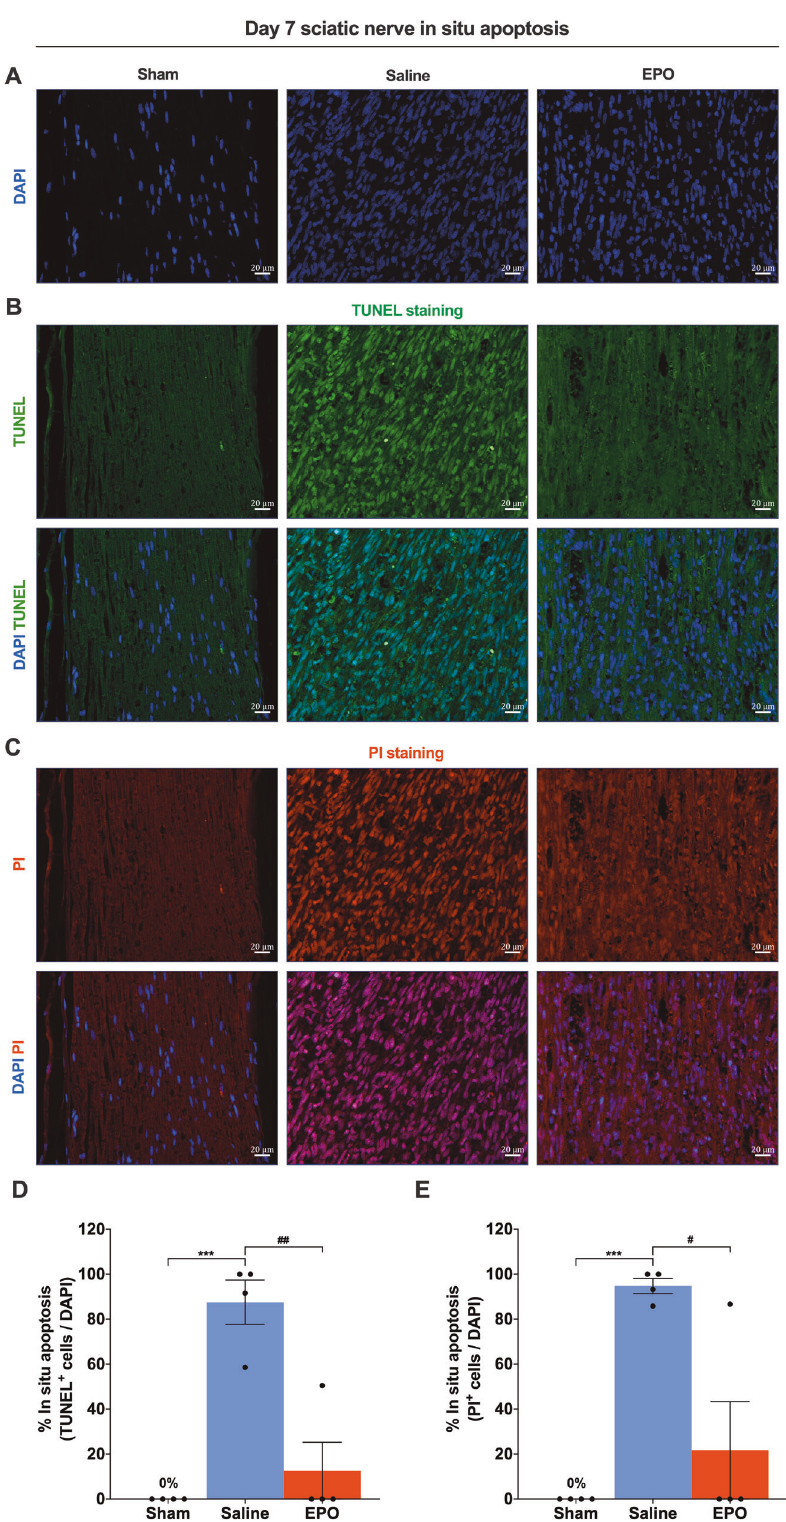
Fig. 2 On day 7, EPO signi fi cantly attenuates SN in situ apoptosis following SNCI. A DAPI staining shows cellular in fi ltration of SN. B , C Representative IF images of TUNEL and PI staining of SN shows that EPO treatment (5000 IU/kg/IP, immediately after surgery and on post- surgery day 1 and 2) signi fi cantly attenuates apoptosis as compared to saline treatment (normal saline, 0.1 ml/IP/mouse) and the result of the percentage of in situ apoptosis (TUNEL and PI + /DAPI) are mentioned in the bar graph ( D , E ). SN of Sham animals shows zero percentage of apoptosis. Each image represents six images from four different SN, a total of 24 images/group. Scale bar, 20 μ m; magni fi cation, 40x. One-way ANOVA, Tukey ’ s multiple comparisons test. Data were expressed as means ± SEM, *** P < 0.0002 vs. sham, # P < 0.05, and ## P < 0.0021 vs. Saline, n = 4/group. Cell Death and Disease (2022)